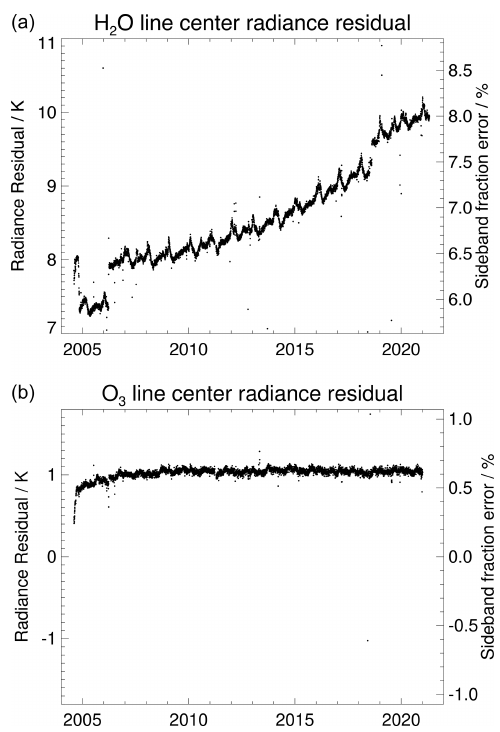
Figure 12. Difference between radiances observed in the center of the water vapor ( a , 183GHz) and ozone ( b , 235GHz) lines and those predicted using the MLS forward model and retrieved tem- perature for limb tangents around 31hPa. The offset and temporal variability in the water vapor case is a measure of changes in the 190GHz sideband fraction from the prelaunch estimate (approxi- mately shown on the right y